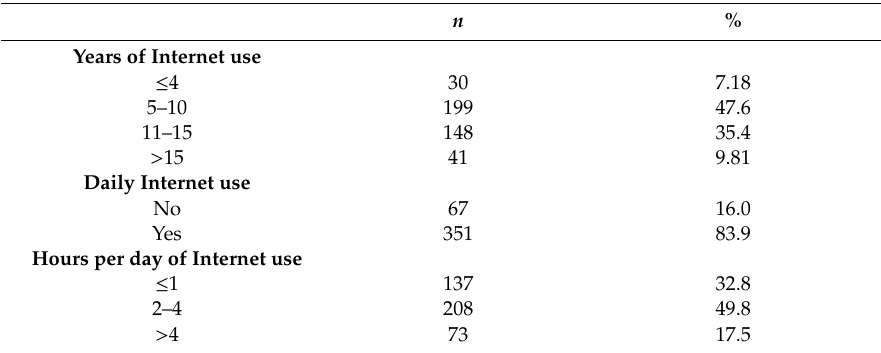
Table 2. Internet usage